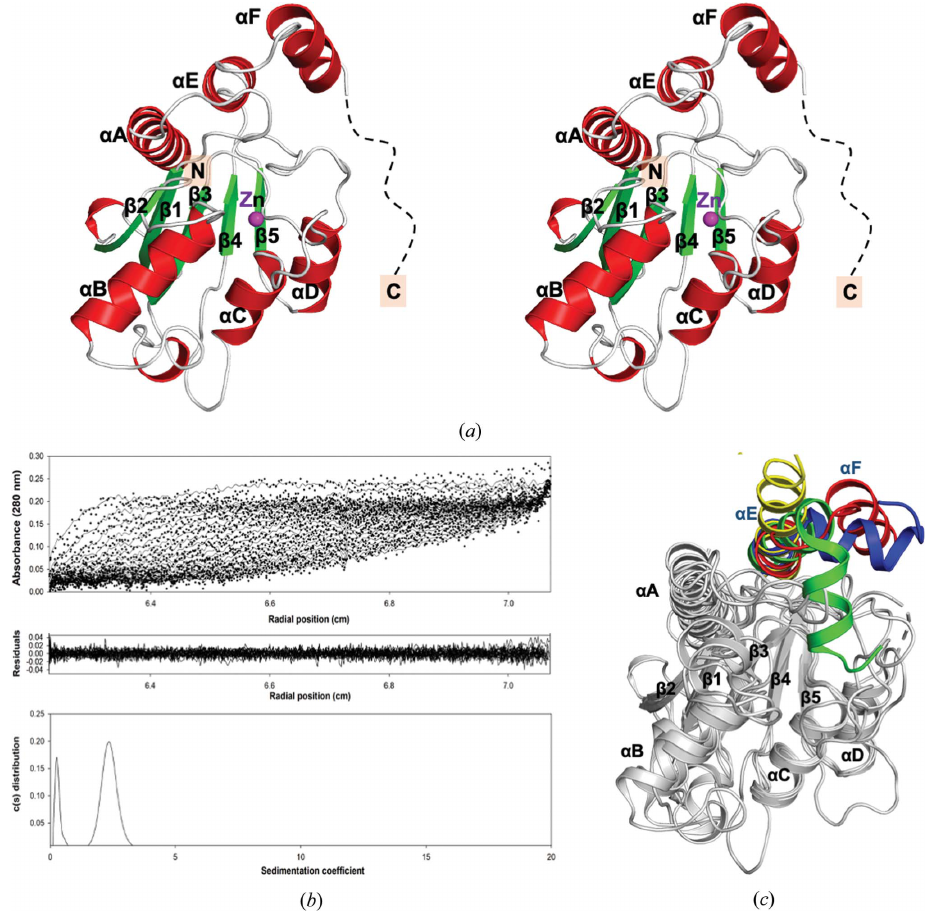
Figure 2 Structure of AoRib2. ( a ) The deaminase domain is made up of a central (cid:3) -sheet flanked by (cid:2) -helices. The endogenous zinc ion in the deaminase domain is shown as a magenta sphere. ( b ) Sedimentation-velocity analysis of AoRib2. The enzyme concentration was 0.3 mg ml (cid:3) 1 in 20 m M PBS pH 7.5. The three panels represent the optical traces (top), the residuals of the model fitting (middle) and the sedimentation- coefficient distribution (bottom). The ultracentrifugation analysis demonstrated that AoRib2 exists as a monomer in solution. ( c ) Structural superposition of AoRib2 (red), yCD (green), BsRibG (blue) and EcTadA (yellow). They share a similar structural core (gray) but show divergence in the C-terminal